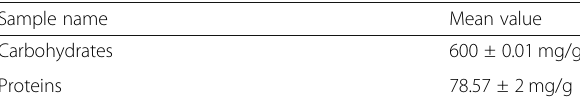
Table 3 Total carbohydrates and protein content in algal biomass from